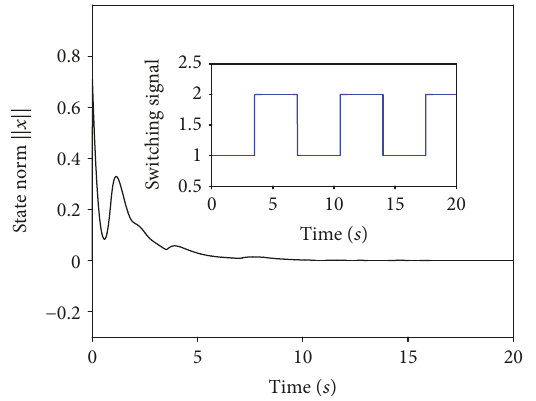
Figure 13: State norm response of the considered SNNs for Example 2 with average dwell time T